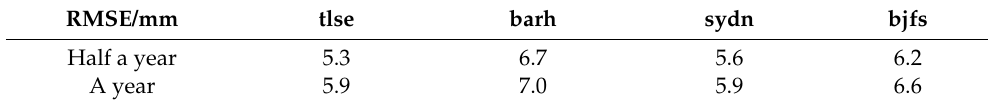
Figure 13. The GARCH residual sequence prediction of sydn and bjfs station. In order to count the prediction effect of the residual GARCH model, the RMSE indicators of GARCH half-year and one-year forecasts are listed in Table 9. The GARCH forecasting accuracy of the residual series of the four stations is at the millimeter level. Table 9. The GARCH residual sequence prediction RMSE of 4 CORS